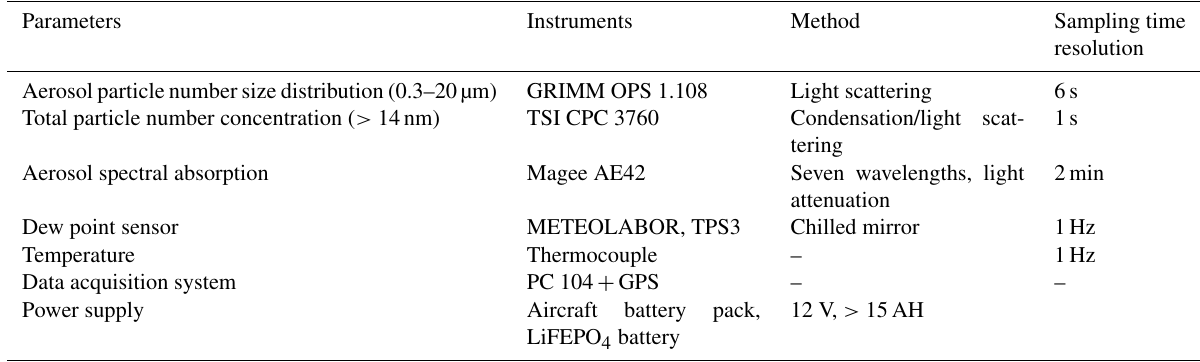
Table 1. Instrument package deployed in the microlight aircraft.